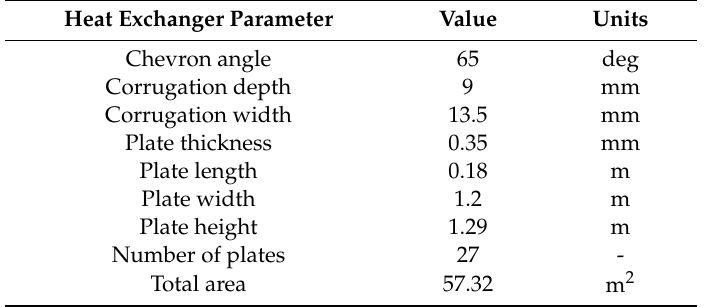
Table 8. Geometrical dimensions of the plate heat exchanger of the LT loop condenser.